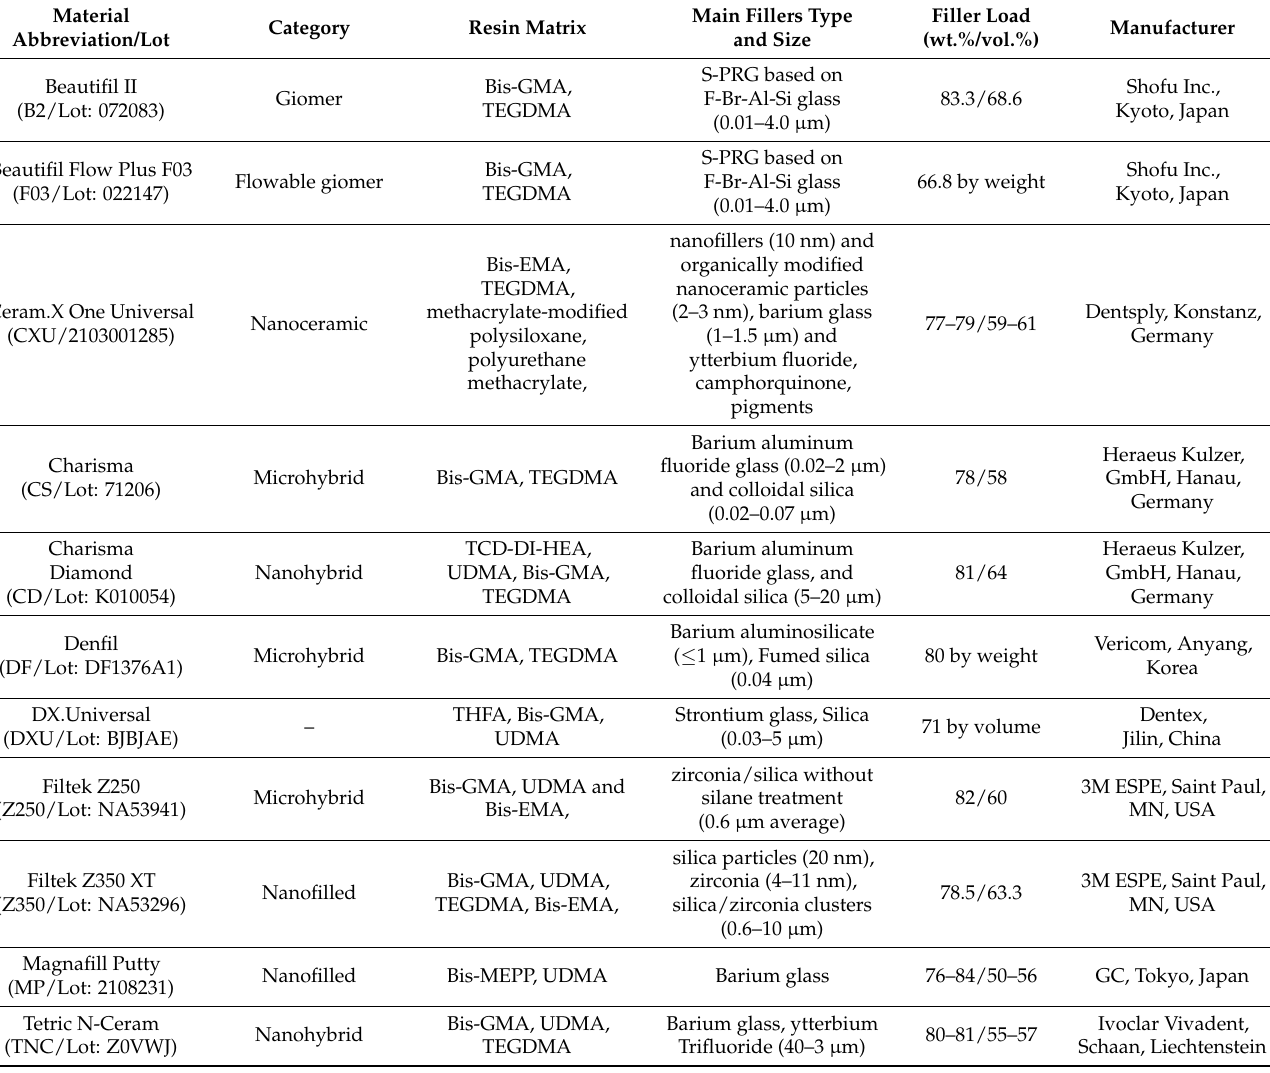
Table 1. Summary of the products used in this